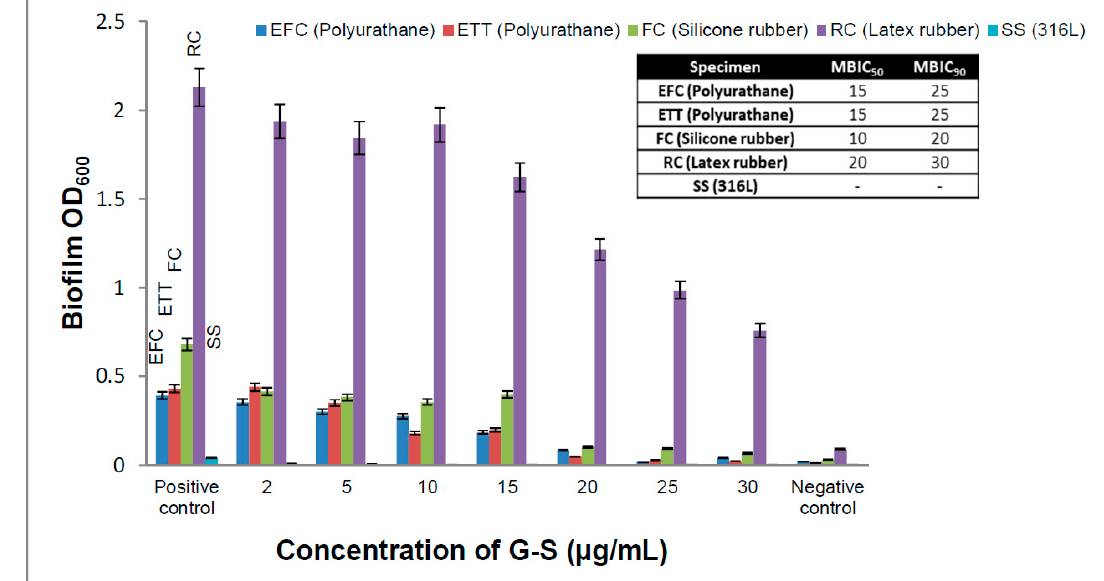
Figure 7. Biofilm inhibition pattern over different externally implanted medical devices (EIDs).